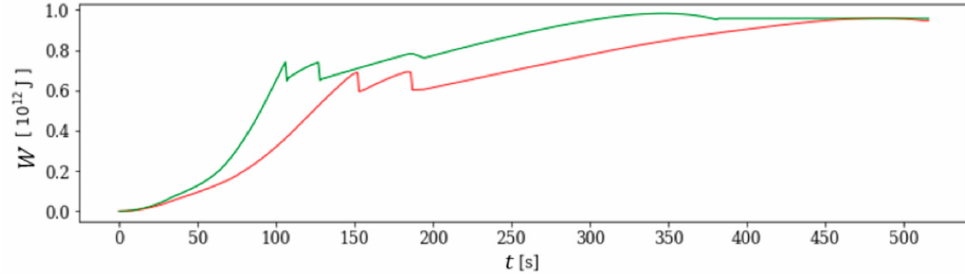
Figure 5. Time dependence of the total energy of the rocket ( W ) for the real (red) and model flight